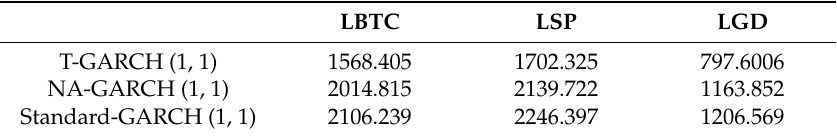
Table 4. The result of Akaike Information Criterion (AIC) scores to select the best model among three different GARCH models. The Standard-GARCH (1, 1) model has maximum values of log-likelihood (LH) from the log-return of Bitcoin (LBTC), log-return of Gold (LGD), and log-returns of S&P 500 (LSP). A higher LH indicates a better fit.